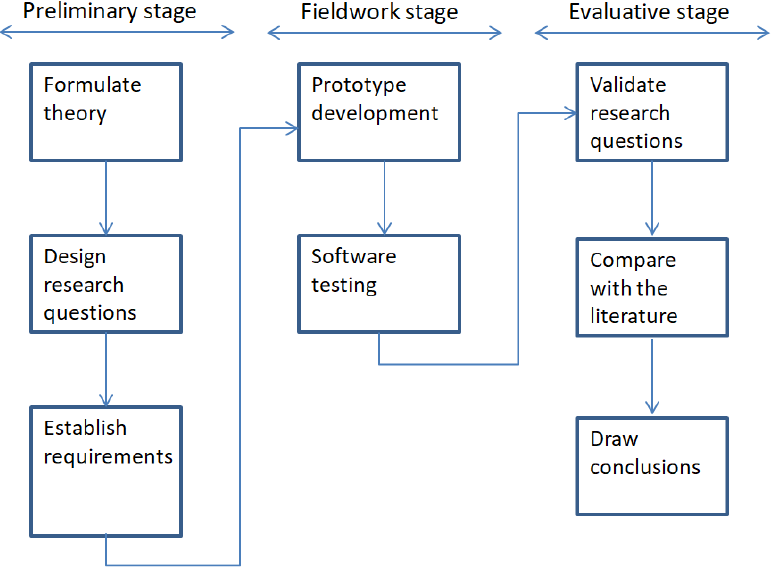
Figure 1. Phases of the adopted